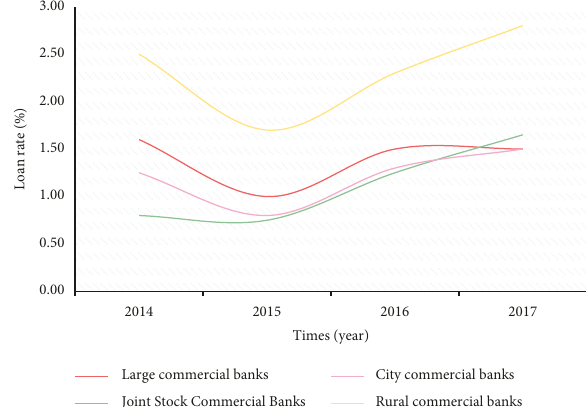
Figure 6: Quarterly nonperforming loan ratio of commercial